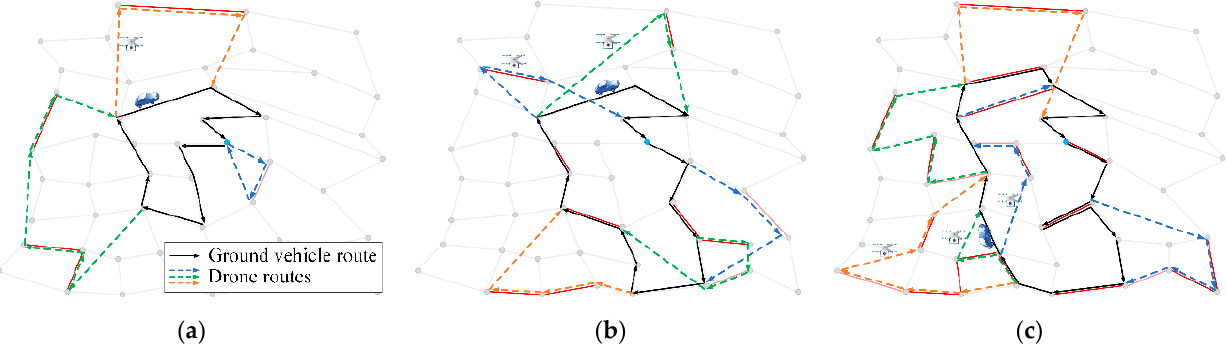
Figure 13. Schematic diagrams of route planning results on different instances with different number of target edges. ( a ) E1-A; ( b ) E2-A; ( c ) E3-A.